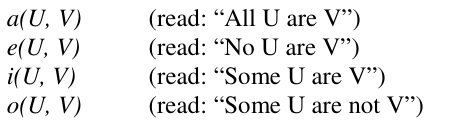
1 st figure: barbara, celarent, darii, ferio, barbarix, feraxo 2 nd figure: cesare, camestres, festino, baroco, camestrop, cesarox 3 rd figure: darapti, disamis, datisi, felapton, bocardo, ferison 4 th figure: bramantip, camenes, dimaris, fesapo, fresison,